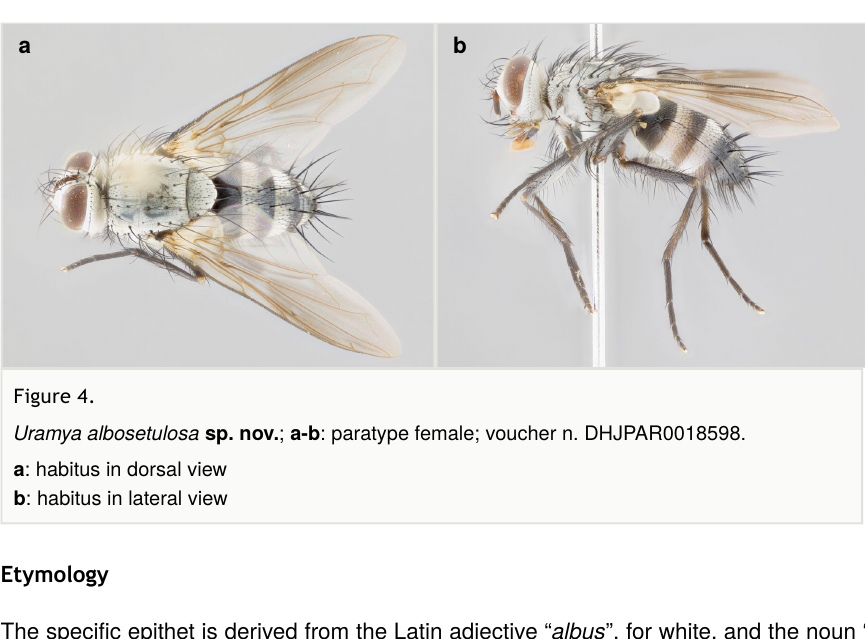
Etymology The speci fi c epithet is derived from the Latin adjective “ albus ”, for white, and the noun “ seta ”, for bristle, in reference to the tuft of white hairs present along the underside of the scutellum in this species.